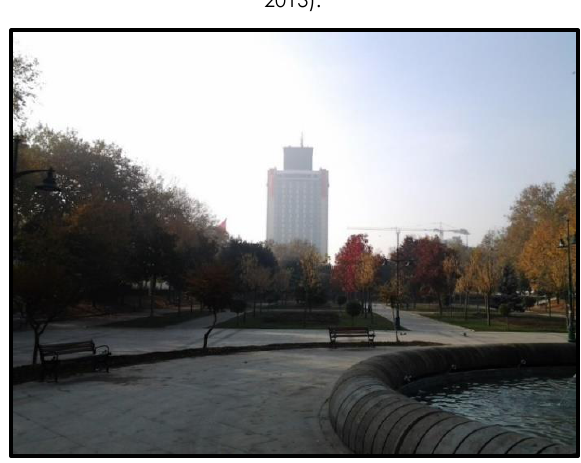
Figure 4. Atatürk Cultural Centre (authors' archive, May 2013).